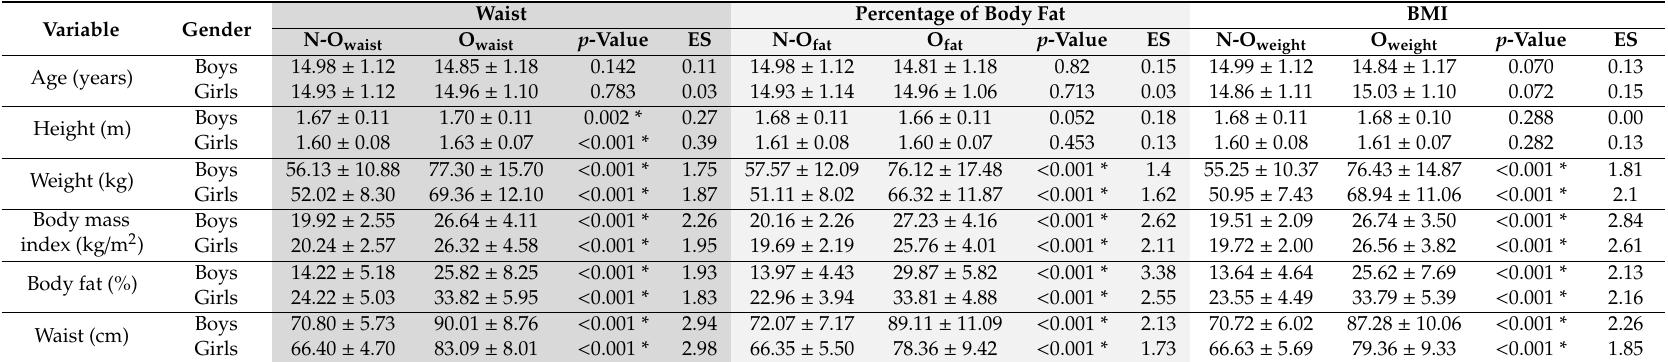
Table 2. Data for age, height, weight, and KIDMED index in over and non-over boys and girls according to di ff erent criteria